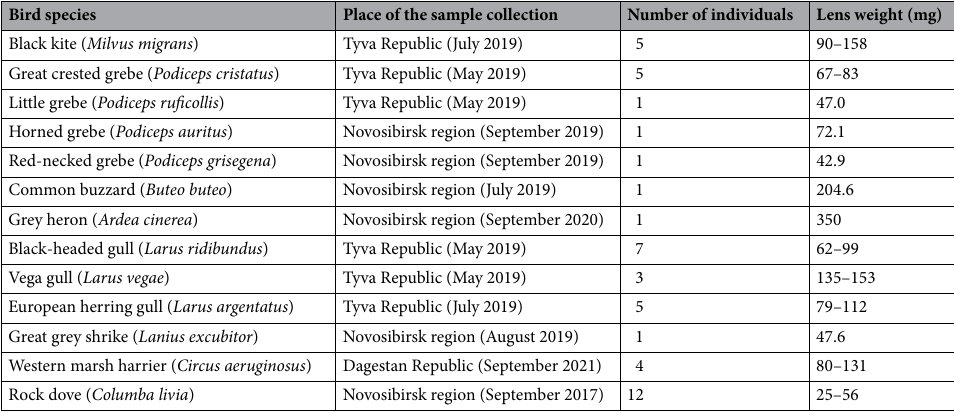
Table 1. Description of the bird species used for the lens metabolomic analysis.